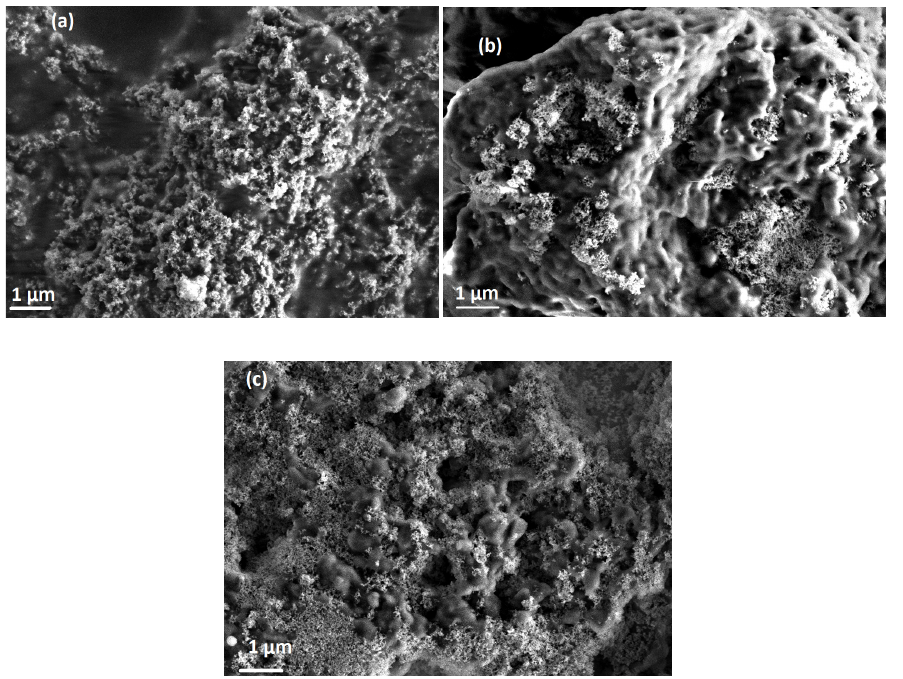
Figure 4. FE ‐ SEM images of PFO/10 wt% MEH ‐ PPV hybrid thin film with: ( a ) 10 wt% STNCs, ( b ) 15 wt% STNCs, and ( c ) 20 wt% STNCs. 15 wt% STNCs, and ( c ) 20 wt% STNCs.